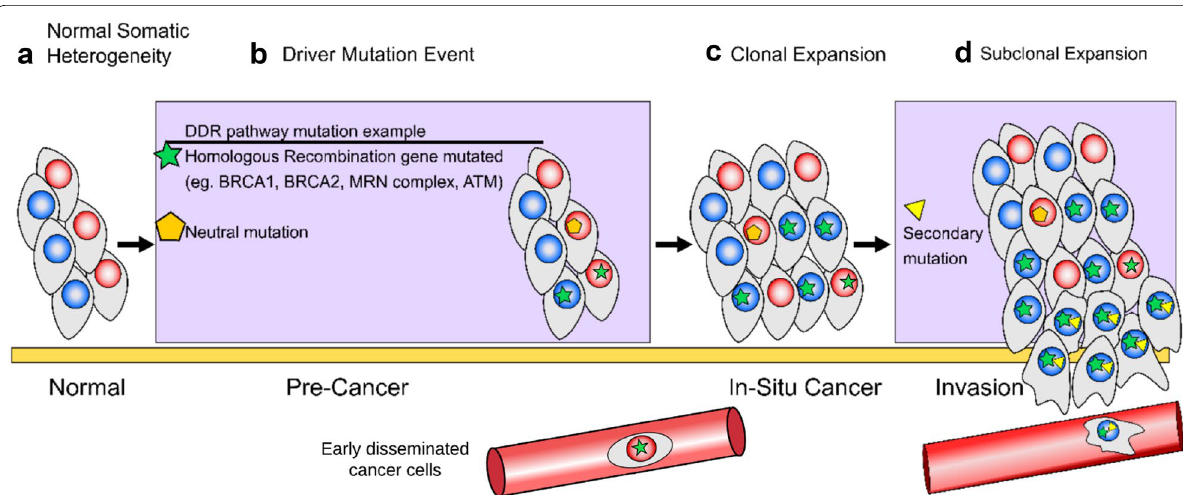
Fig. 1 Heterogeneity and metastasis. a Normal healthy tissues have a naturally occurring degree of somatic heterogeneity. These mutations can arise due to environmental factors and inaccurately resolved errors in transcription or replication. b As mutations stochastically arise, some will be neutral, thus having no apparent affect on the phenotype, while others may occur in ‘driver’ gene regions and have more immediately observable traits. For example, mutated DNA damage response (DDR) genes can drive tumorigenesis because they leave the cell without the necessary path- ways to resolve lesions. c Driver gene mutations can confer an advantage in the founder clone and promote subsequent expansion. d Secondary mutations that occur in subclones further drive heterogeneity and can lead to metastasis. Additionally, recent research suggests that metastases may also derive from early disseminated cancer cells